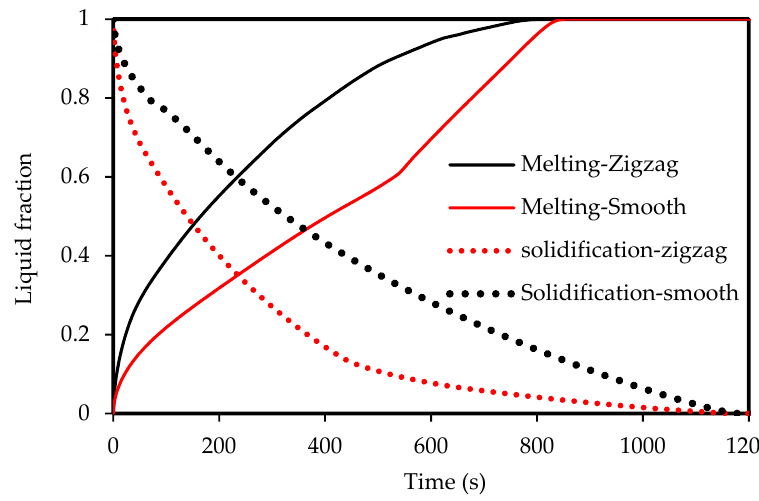
Figure 16. Evolution of the liquid-fraction in both melting and solidification processes for both Zigzag and smooth channels for the case 2 W width channel.